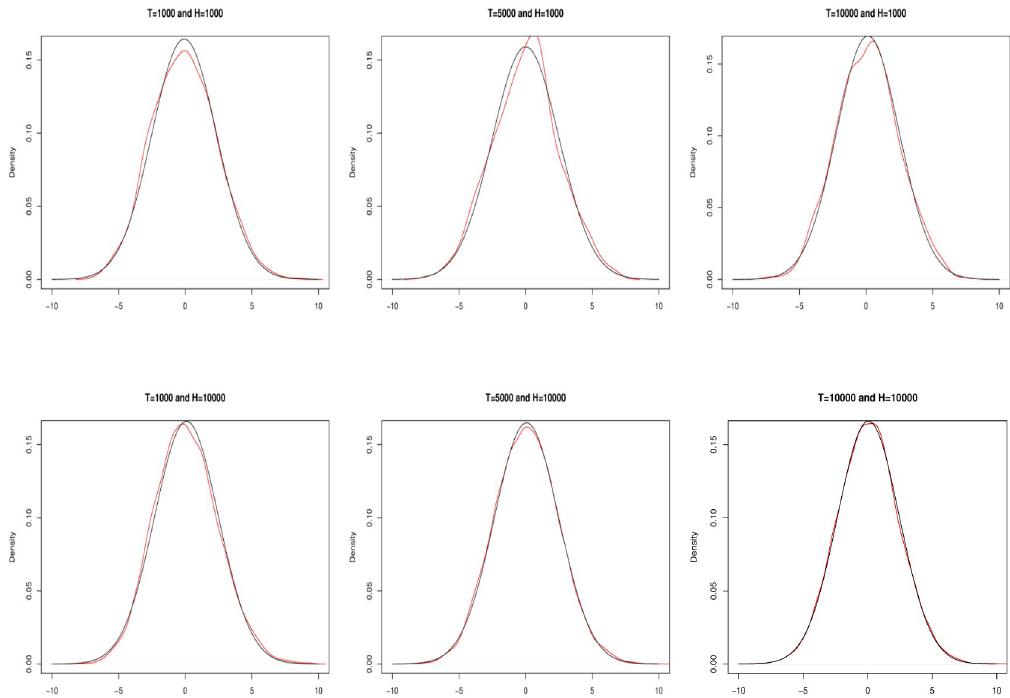
Fig 7. Convergence in distribution. Kernel densities (red line) of the centered estimates against a corresponding Gaussian distribution (black line) for all the combinations of the sample size and replications (indicated in the top of each plot). https://doi.org/10.1371/journal.pone.0278599.g007 Table 1. Estimation uncertainty step 1.